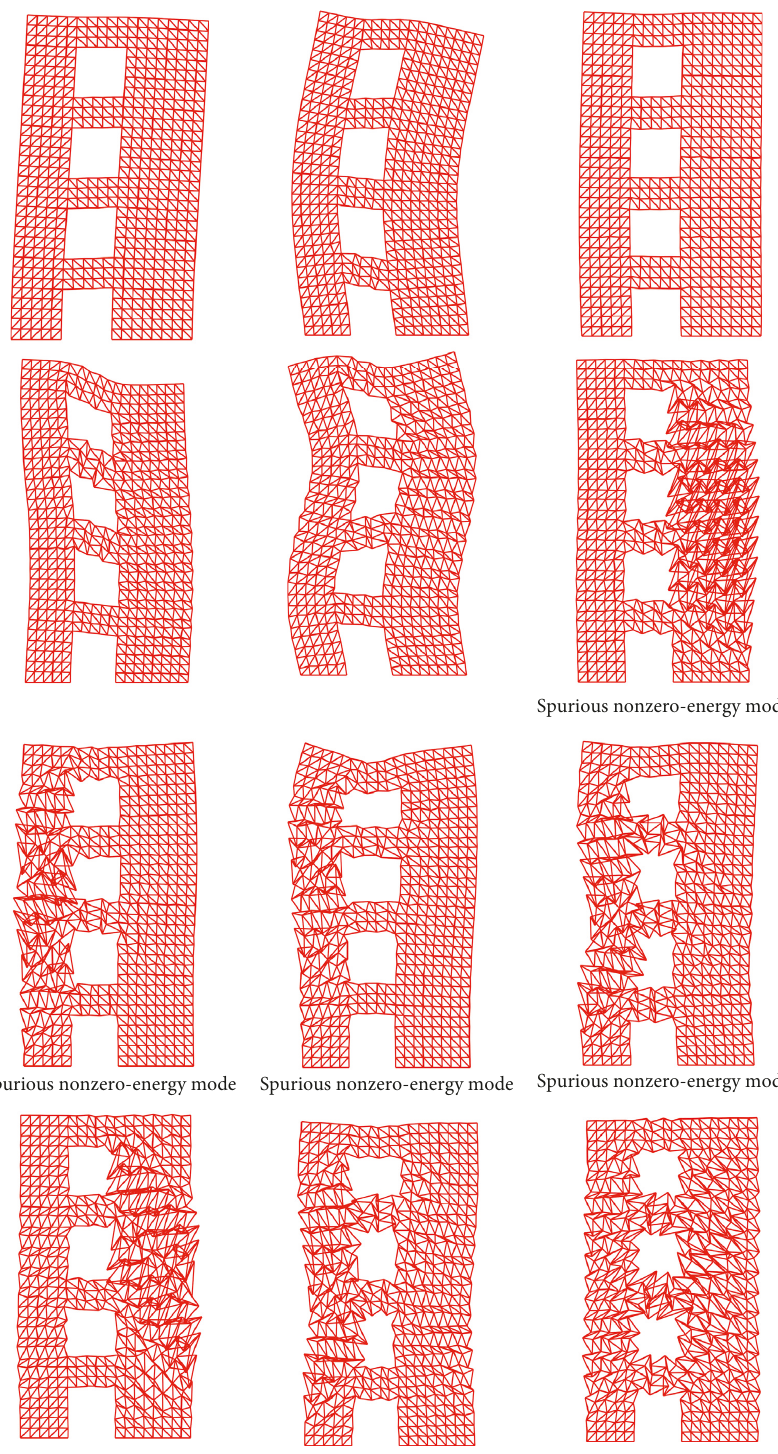
Figure 26: First 12 modes of shear wall by